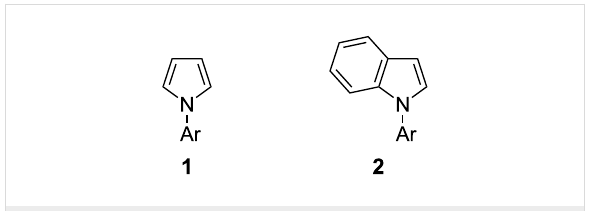
Figure 1: Substrates involved in deproto-metallation